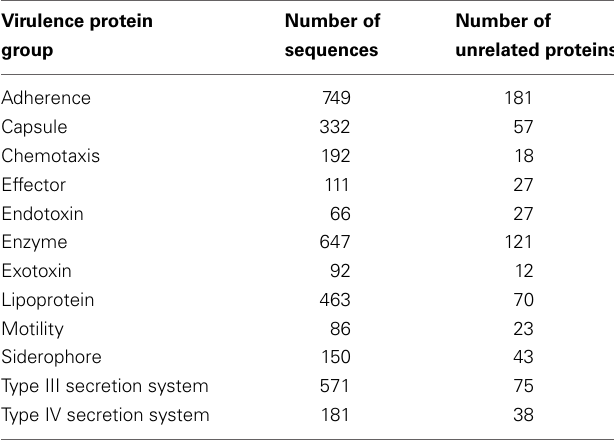
Table 2 | Functional search terms used to retrieve and download protein sequences from virulence factor database MvirDBbrowser